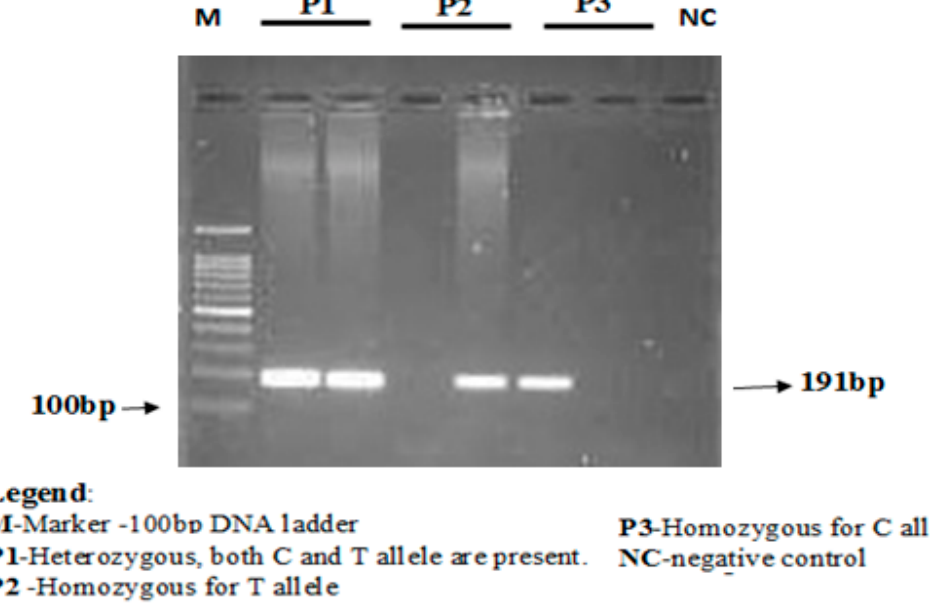
Figure 1. Genotyping of the LDLR rs688 (C/T) polymorphism by an allele-specific PCR assay. A 191-bp DNA fragment indicated the presence of the allele, while amplification failure indicated the bsence of the allele in the sample. In a 2% w / v agarose gel, L indicates molecular size standard, C and T indicate the product from reaction C and reaction T, respectively, amplifiled from selected DNA sample of each possible genotypes (CC, CT and TT) and H 2 O (negative control).